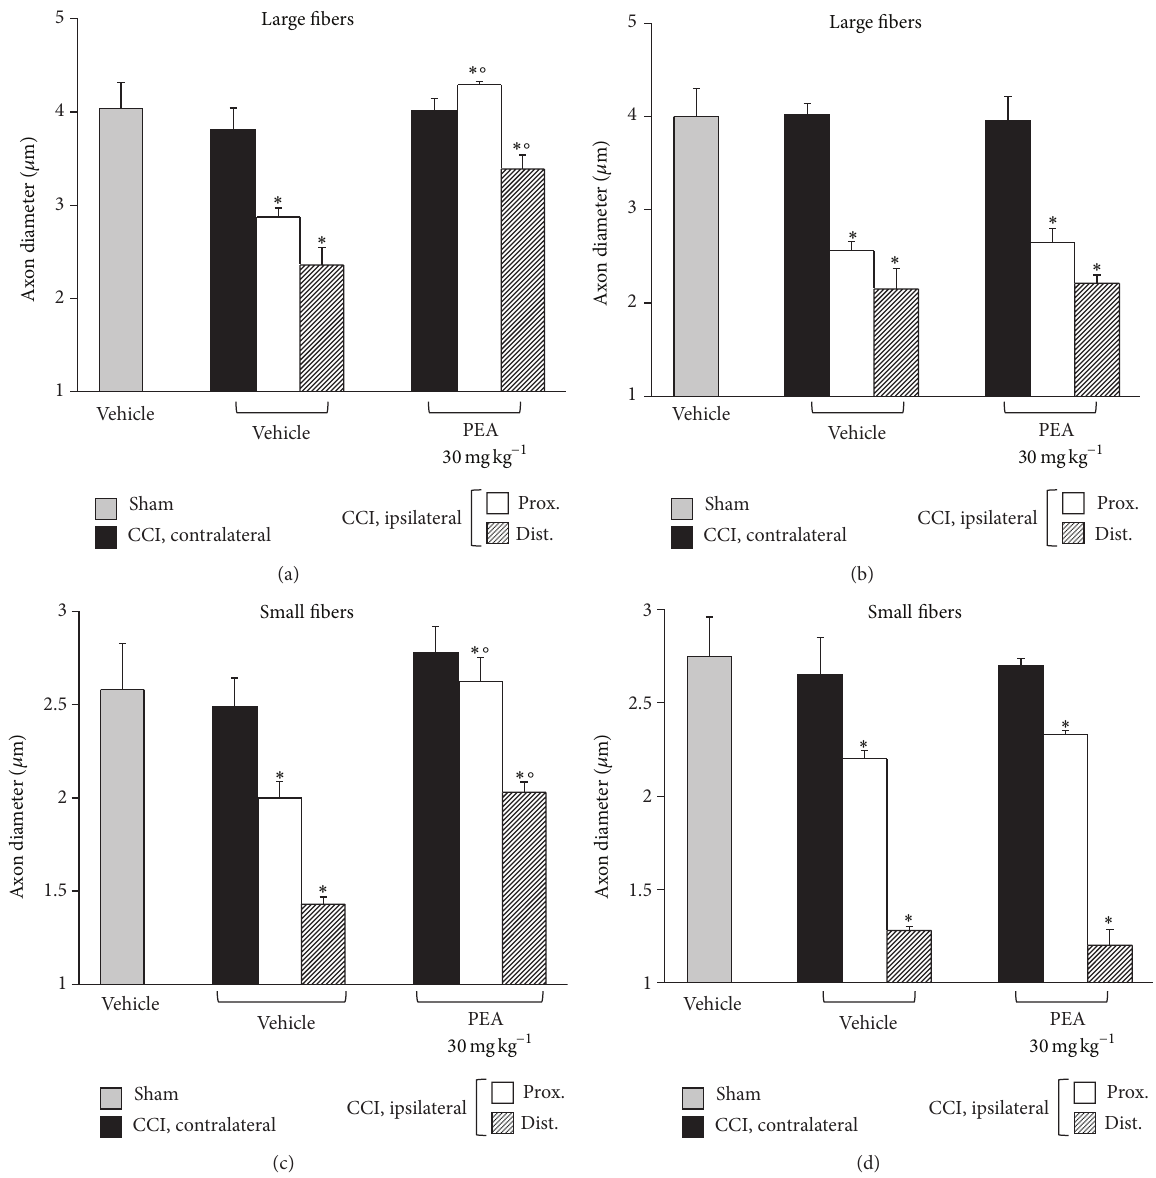
Figure 4: Morphometry: axon diameters. Nerve sections (5 𝜇 m) of osmium-fixed tissues were analyzed. The distal and the proximal tract of the ipsilateral ligated nerve (CCI) was compared with the contralateral and with the sciatic nerve of sham-operated animals (sham). Axon diameters of large and small fibers of PEA-treated (30mg kg −1 s.c. for 14 days) wild-type ((a) and (c)) and PPAR- 𝛼 null ((b) and (d)) mice in respect to saline-treated CCI and saline-treated sham animals. Quantitative analysis was performed evaluating 5 animals for each group. ∗ 𝑃 < 0.05 was considered as significantly different from sham, vehicle-treated mice. ∘ 𝑃 < 0.05 was considered as significantly different from CCI, vehicle-treated